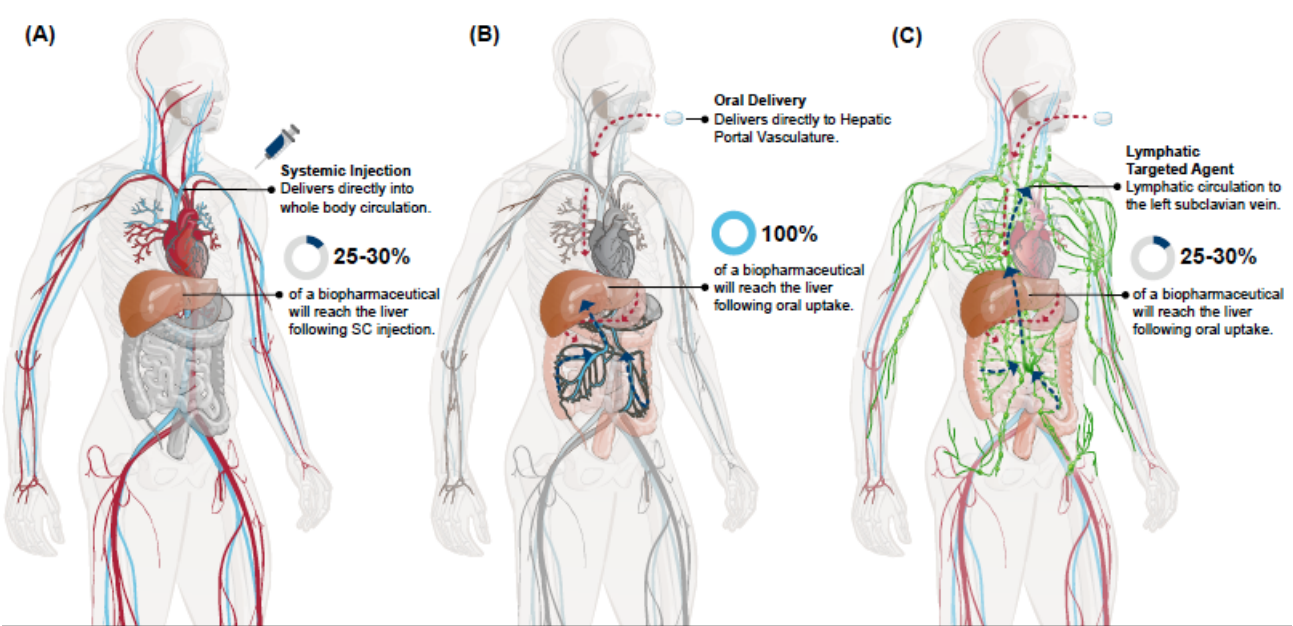
Figure 1. Comparison of parenteral and oral entry routes on initial vascular distribution. Relative distribution of a biopharmaceutical following ( A ) parenteral administration, ( B ) oral uptake of hydrophilic agents into the hepatic portal vein, and ( C ) oral uptake of hydrophobic agents into lymphatic vessels.